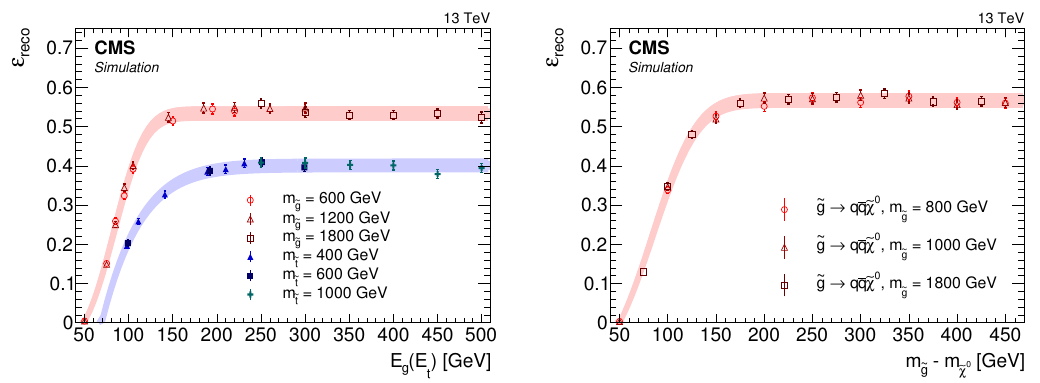
Figure 2 . The " reco values as a function of E g or E t (left), and m (cid:0) m (right), for g and e t e e g e (cid:31) 0 R-hadrons that stop in the EB or HB, in the MC simulation, for the calorimeter search. The " reco values are plotted for the two-body gluino and top squark decays (left) and for the three-body gluino decay (right). The shaded bands correspond to the systematic uncertainties, which are described in section 7. m [GeV] " " Expected events stopping reco e g